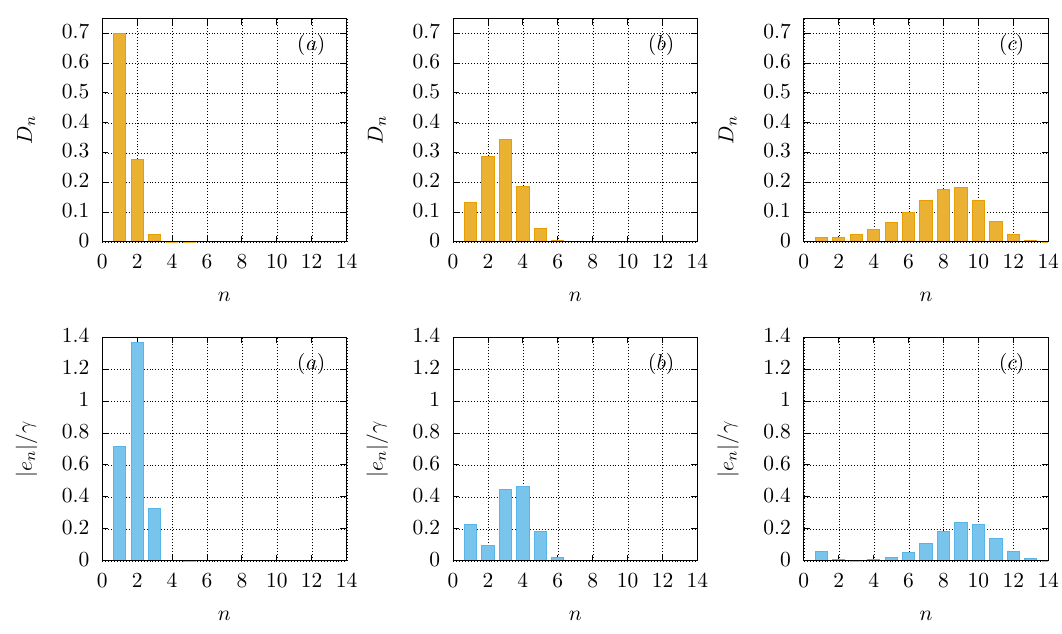
/γ of the n are always n